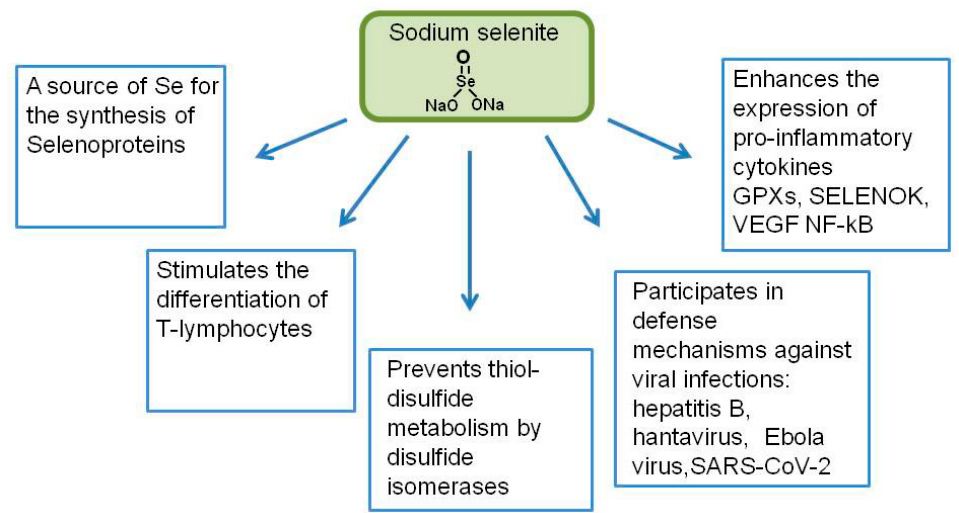
Figure 2. Participation of sodium selenite in the regulation of the gene expression and activation of immune system. GPXs—glutathione peroxidases; NF- κ B—nuclear factor kappa-light-chain-enhancer the immune system. GPXs—glutathione peroxidases; NF- κ B—nuclear factor kap- of activated B cells; SELENOK—selenoprotein K; VEGF—vascular endothelial growth pa-light-chain-enhancer of activated B cells; SELENOK—selenoprotein K; VEGF—vascular endo- thelial growth factor.